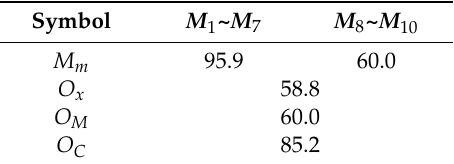
Table 4. HI of the three layers in